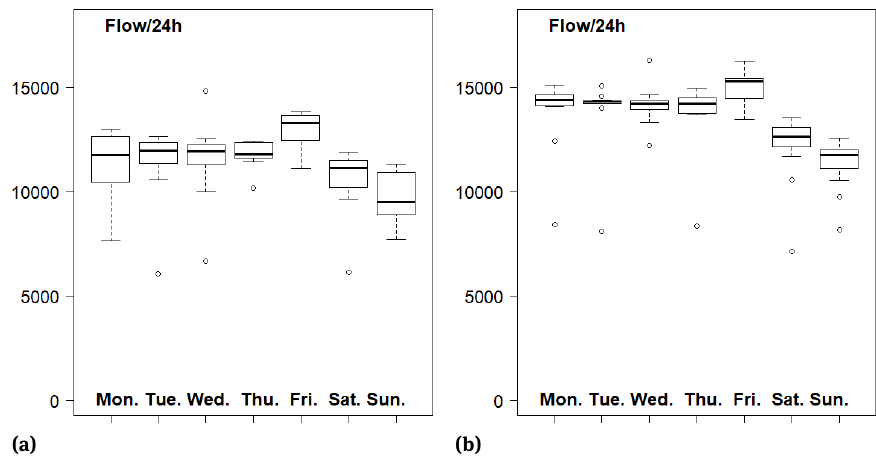
Figure 3: Traflc flow box plots for passenger vehicles, determined for each day of the week a) in 2012, b) in